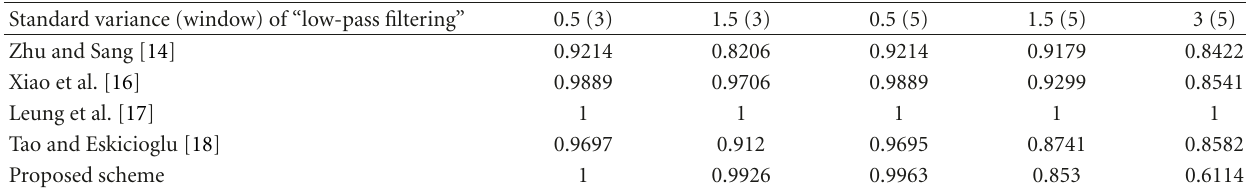
Table 6: Experiment results comparison under low-pass filtering (NC values).